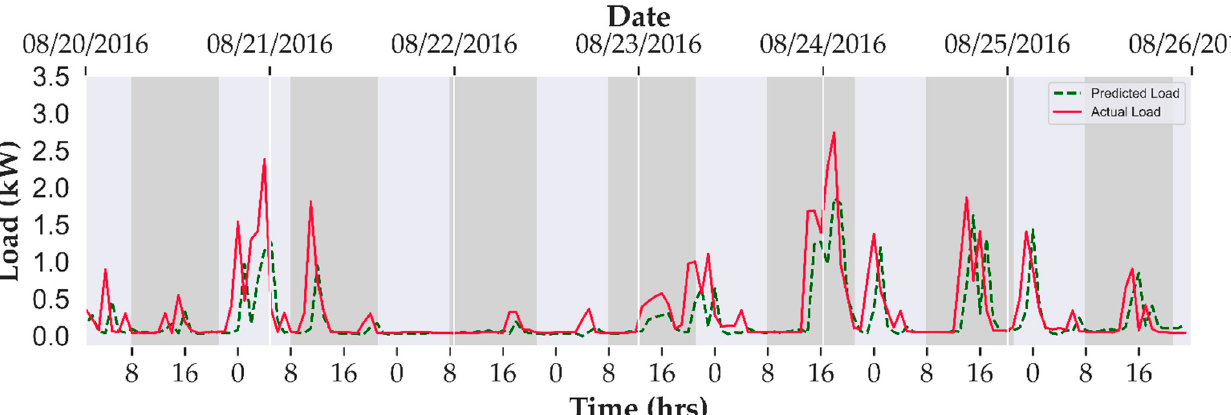
Figure 11. Load Forecasting for an extreme summer week.